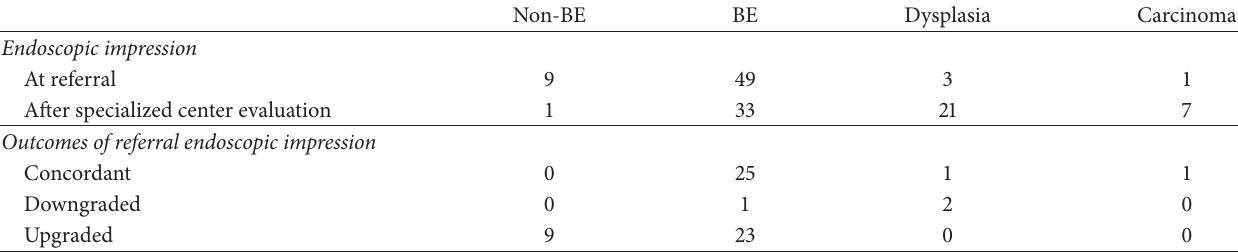
Table 2: Comparison of endoscopic impression at referral and after specialized center evaluation.